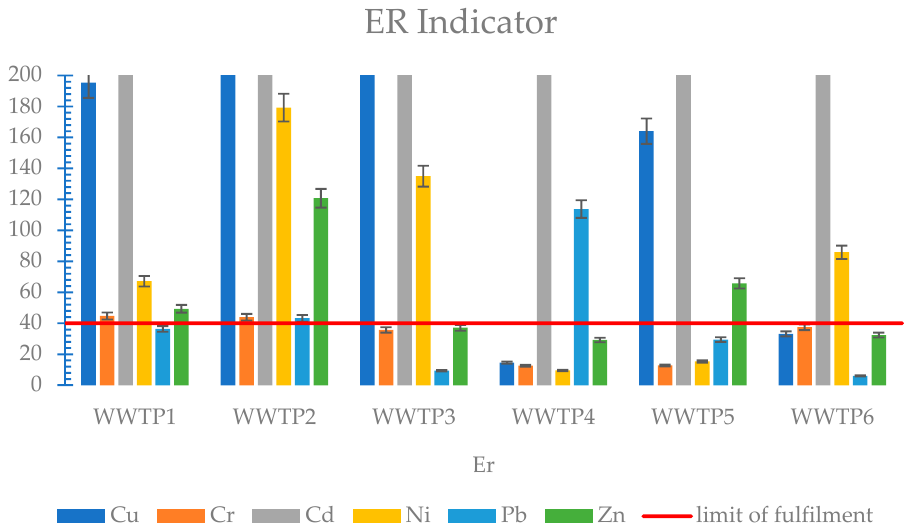
Figure 4. ER indicator of heavy metals in sewage sludge.